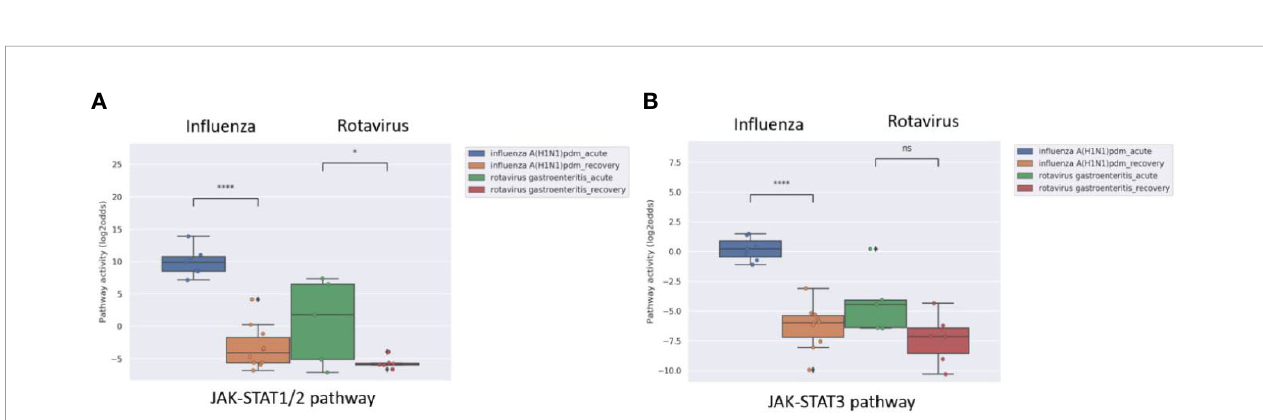
FIGURE 8 | JAK-STAT1/2 (A) and JAK-STAT3 (B) pathway activity analysis of dataset GSE50628 (48): In fl uenza A(H1N1)pdm09 or rotavirus (gastroenteritis) infected patients. Whole blood samples were collected from patients on the day of admission in the acute phase (in fl uenza, 1 – 3 days from disease onset; rotavirus, 2 – 4 days from disease onset and recovery phase (in fl uenza, 4 – 9 days from disease onset; rotavirus, 7 – 11 days from disease onset), and were used for analysis. Pathway activity score on Y-axis in log2odds. Two sided independent t-tests were performed; p-values are indicated in the fi guresas *p < 0.05; ****p < 0.0001 or ns (not signi fi cant).